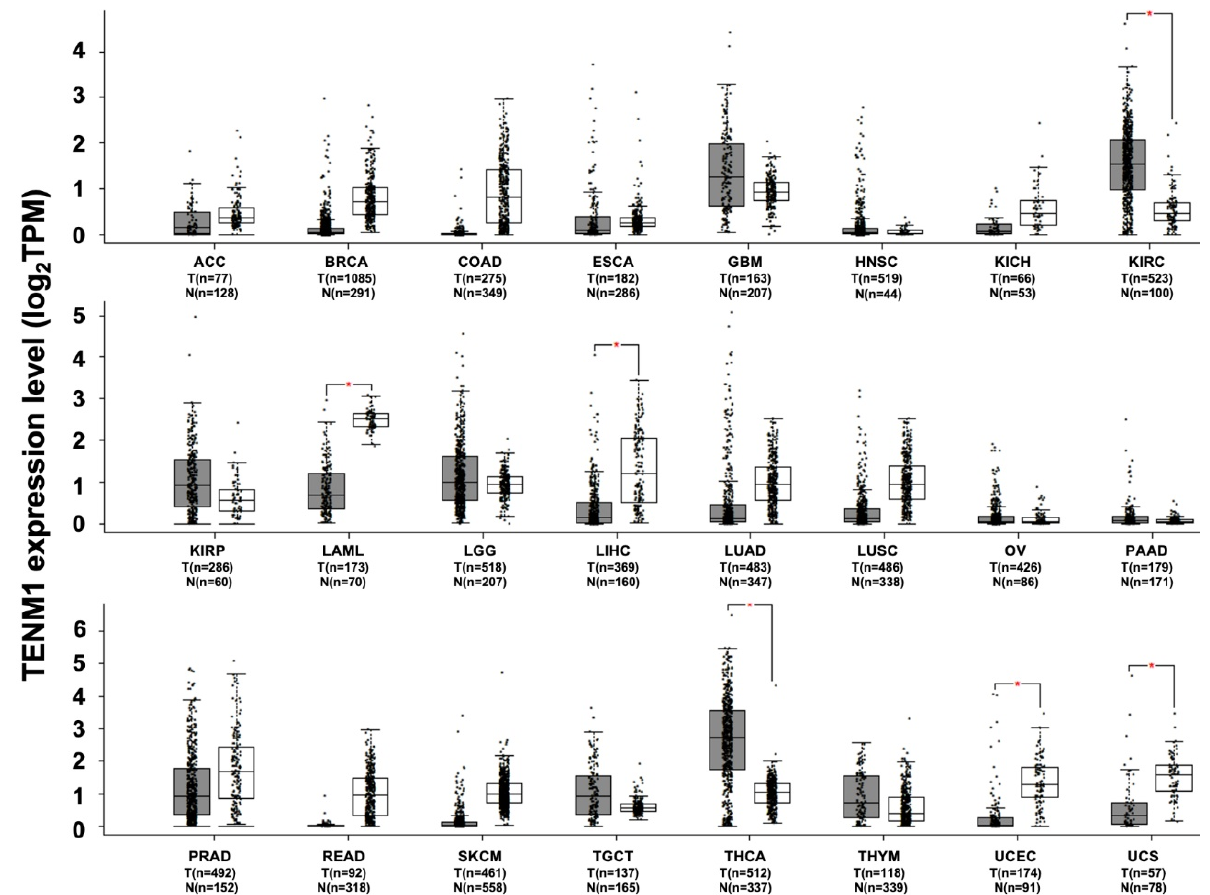
Figure 2. TENM1 expression in different datasets of tumors and normal samples. TENM1 expression level, shown as log2 of transcript per million mapped reads value, was analyzed from RNA sequencing data of tumors and normal samples from the TCGA and the GTEx projects, using a web standard processing pipeline [43]. Tumor (T) and normal samples (N) are represented in grey and white box plots, respectively, each dot representing a sample ( n = number of samples within the dataset). Statistical differential analysis was performed using the Gene Expression Profiling Interactive Analysis (GEPIA) default recommended parameters, one-way ANOVA, |Log2FC| ≥ 1 and p -value ≤ 0.01. Datasets description: ACC; Adrenocortical carcinoma. BRCA; Breast invasive carcinoma. COAD; Colon adenocarcinoma. ESCA; Esophageal carcinoma. GBM; Glioblastoma multiforme. HNSC; Head and neck squamous cell carcinoma. KICH; Kidney chromophobe. KIRC; Kidney renal clear cell carcinoma. KIRP; Kidney renal papillary cell carcinoma. LAML; Acute myeloid leukemia. LGG; Brain lower grade glioma. LIHC; Liver hepatocellular carcinoma. LUAD; Lung adenocarcinoma. LUSC; Lung squamous cell carcinoma. OV; Ovarian serous cystadenocarcinoma. PAAD; Pancreatic adenocarcinoma. PRAD; Prostate adenocarcinoma. READ; Rectum adenocarcinoma. SKCM; Skin cutaneous melanoma. TGCT; Testicular germ cell tumors. THCA;